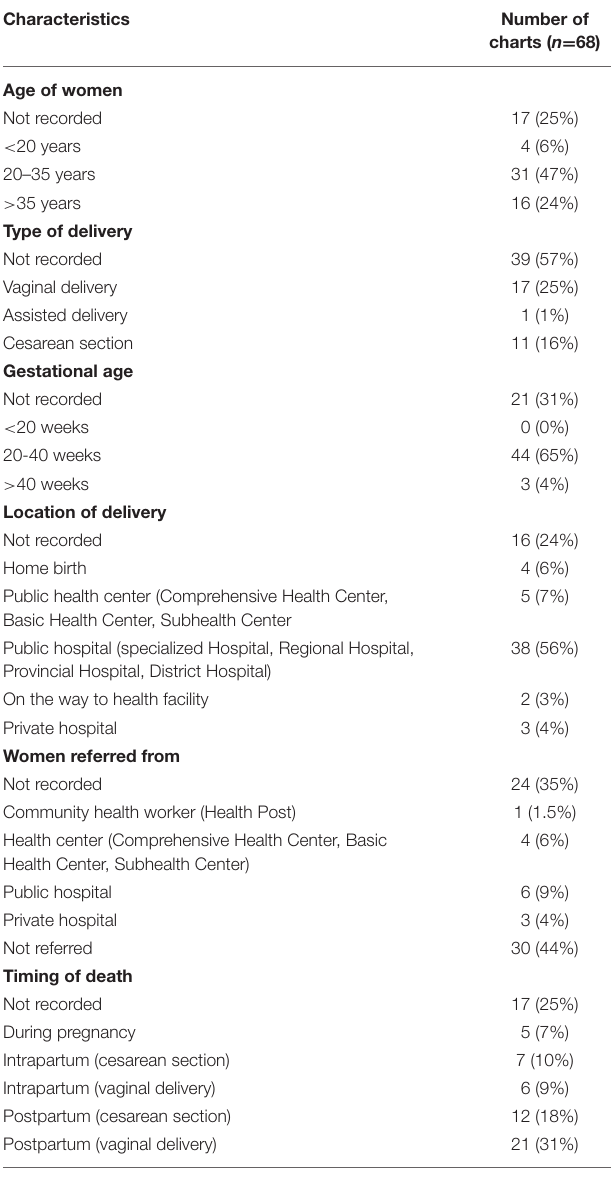
TABLE 2 | Maternal mortality case characteristics recorded in selected charts.